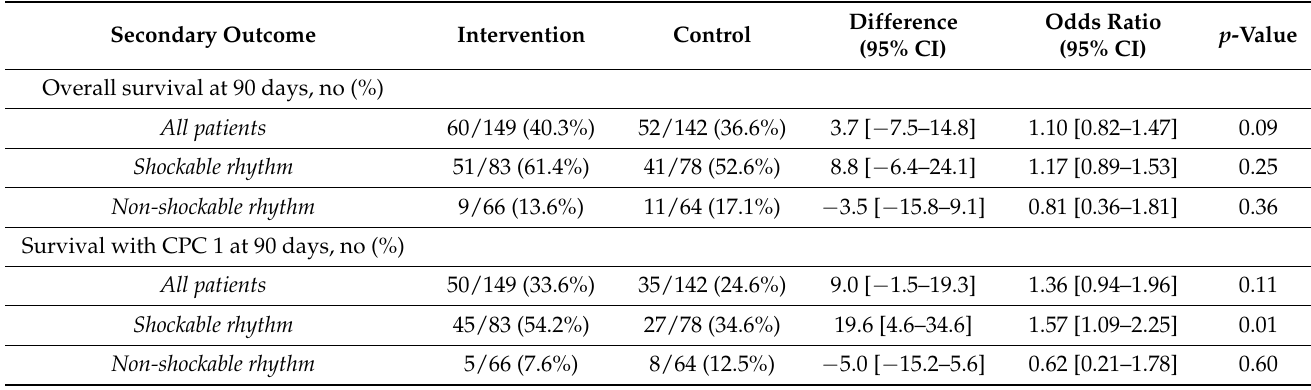
Table 4. Secondary outcomes in the population, which are presented as odds ratio (OR) and 95% confidence intervals (CI). Data are presented in all patients and in the subgroup of patients with shockable (ventricular fibrillation or pulseless ventricular tachycardia) and non-shockable (asystole and pulseless electric activity) initial rhythm. CPC = Cerebral Performance